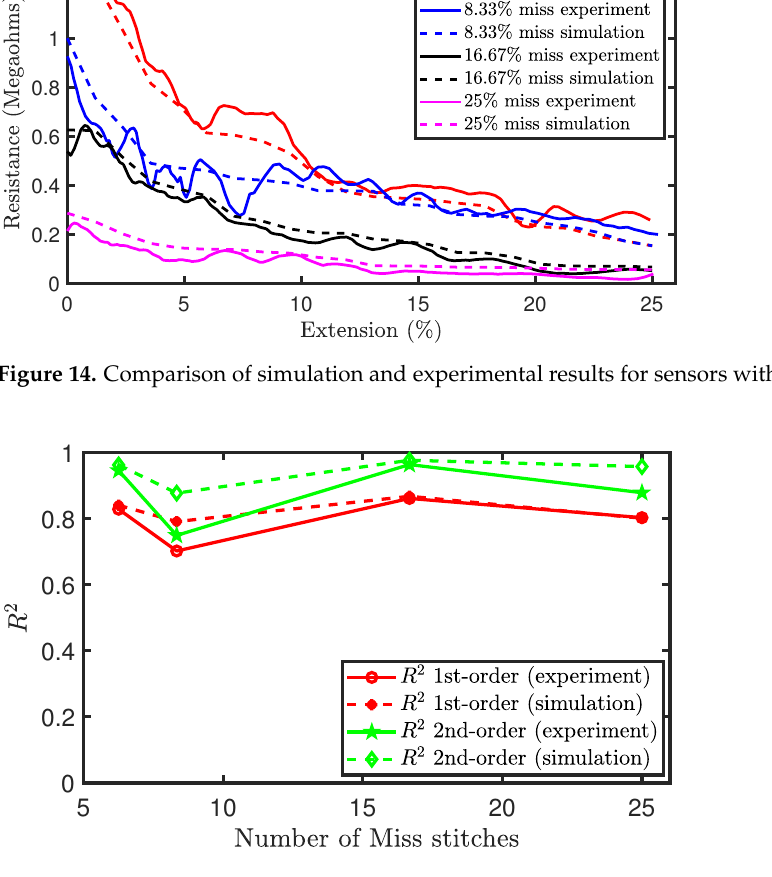
Figure 15. Polynomial fit of the piezoresistive behaviour of sensors with miss stitches.